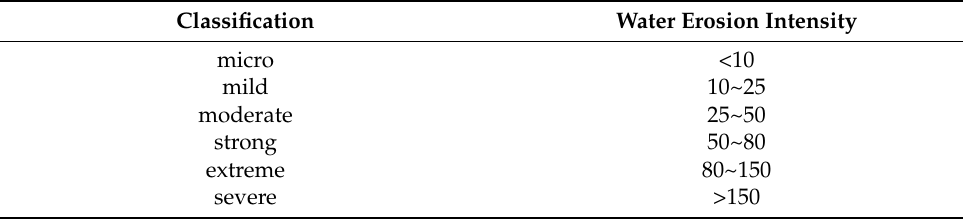
Table 1. The gradation and classification of soil water erosion intensity (t/hm 2